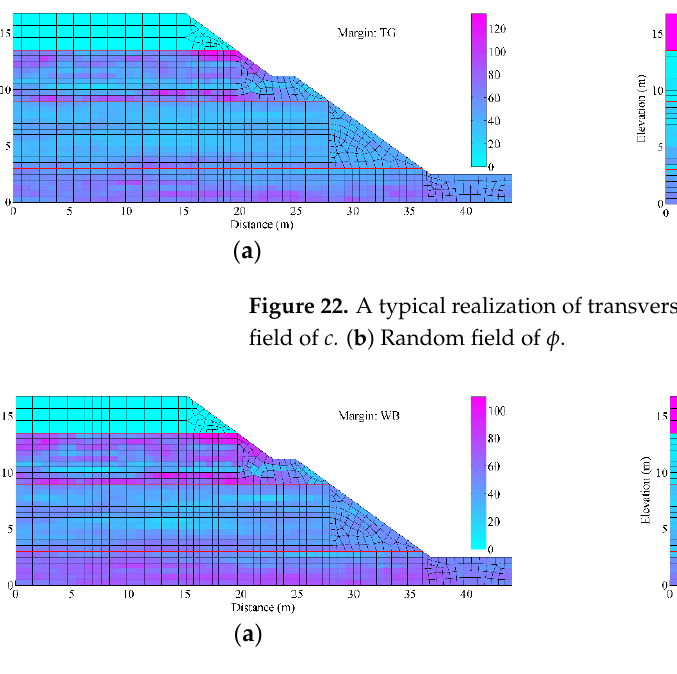
Figure 24. Average errors of the statistics with respect to the three clay layers deduced by different strategies. Table 8. Statistics of CCRF variables associated with different strategies. Copulas Soil layers